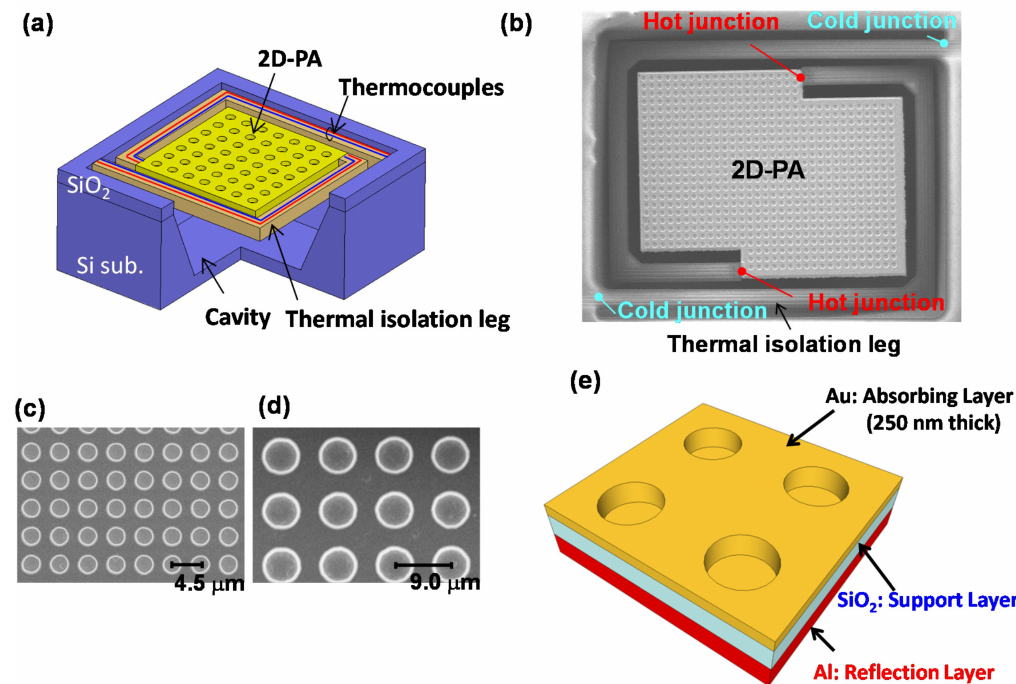
Figure 4. ( a ) Schematic diagram of the uncooled IR sensor (thermopile) with Au-based 2D-PA; ( b ) SEM image of the microelectromechanical systems (MEMS)-based thermopile with 2D-PA. Magnified SEM images of the 2D-PAs of ( c ) (ii) and ( d ) (vii); ( e ) Schematic diagram of the